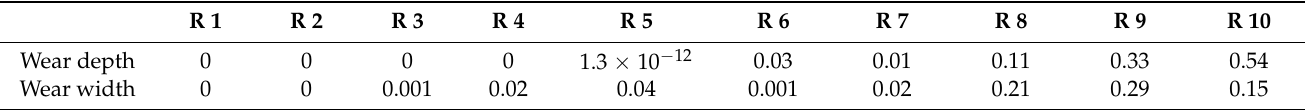
Figure 13. Normality analysis of wear width. Table 3. Summary of p -value based on Chi-squared test.